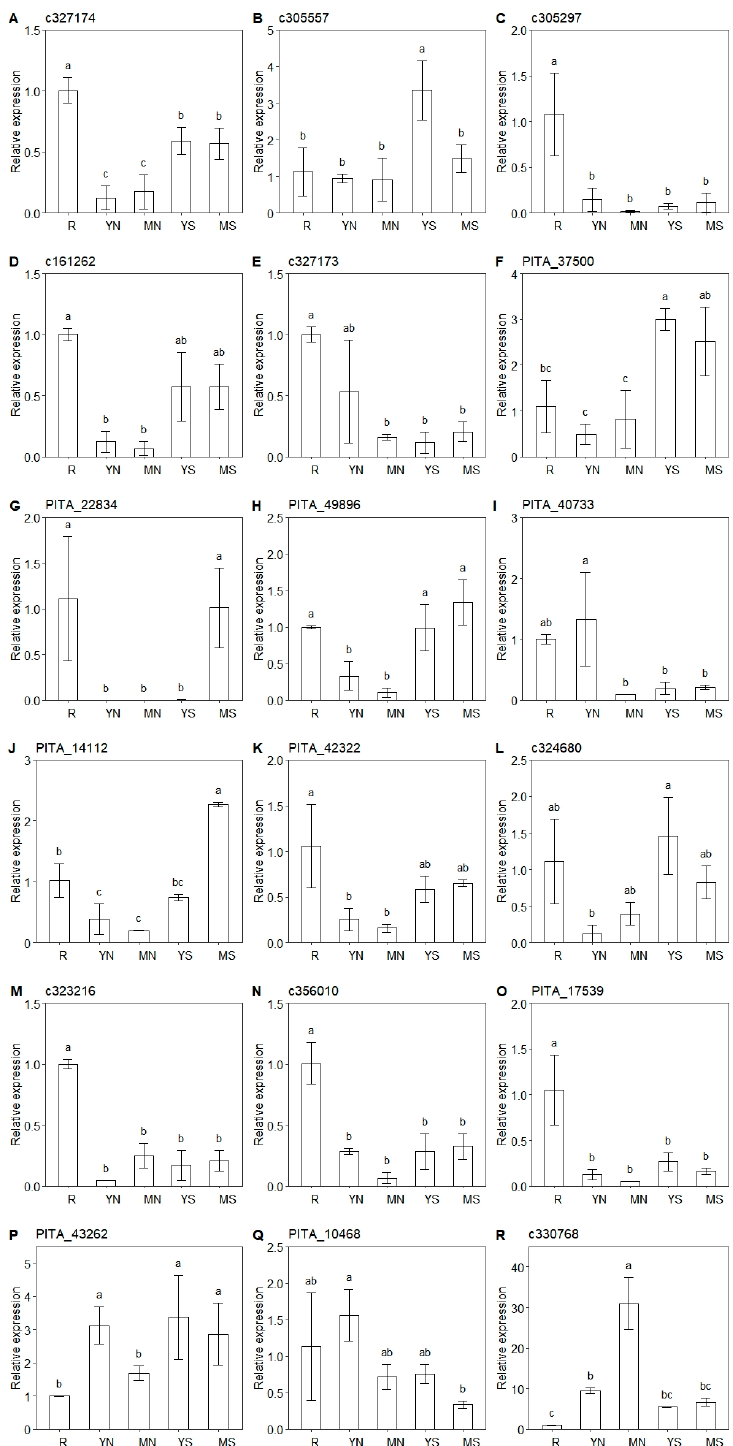
Figure 5. Expression analysis of 18 CYP720B genes by RT–qPCR. The gene names beginning with c and PITA stand for the CYP720B genes of slash pine and loblolly pine. UBI and 18S rRNA were selected as the reference gene. Data were normalized and vertical bars indicate the standard deviation of biological replicates ( n = 3). Statistically significant differences are indicated with different letters (Tukey’s test, p < 0.05). ( A – J ) belonged to clade I, ( K ) belonged to clade II, ( L – Q ) belonged to clade III, and ( R ) belonged to clade IV. Transcript quantification was measured in young needles (YN), mature needles (MN), young stems (YS), mature stems (MN), and roots